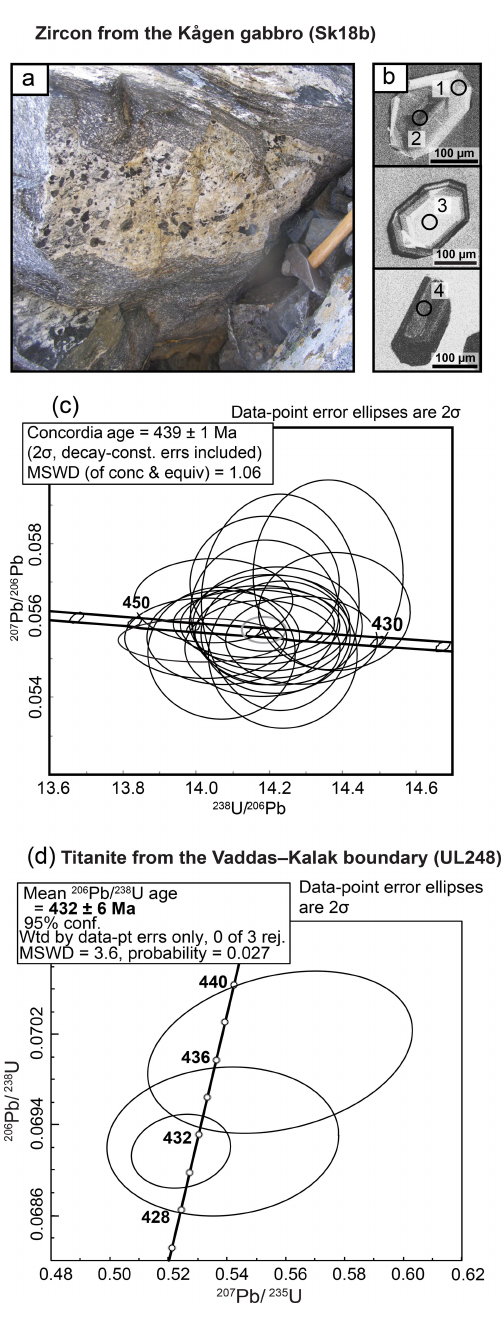
Figure 12. Ages related to intrusion and shearing in the Vaddas Nappe. (a) Photograph of the sampled gabbroic pegmatite (sam- ple Sk18b); the hammer head is 15cm long. (b) CL images of single zircon grains with spot analyses shown. The spot analyses have the following 206 Pb / 238 U dates: (1) 438 ± 2 . 5, (2) 438 . 2 ± 2 . 7, (3) 439 . 1 ± 2 . 5, and (4) 444 . 4 ± 2 . 8Ma. (c) Terra–Wasserburg dia- gram for SIMS zircon analysis from gabbroic pegmatite (sample SK18b) with Concordia age calculated showing the age of the Kå- gen gabbro intrusion into the Vaddas Nappe. (d) Concordia diagram for U-Pb TIMS analyses of titanites from the Vaddas–Kalak bound- ary (sample UL248) with mean 206 Pb / 238 U age